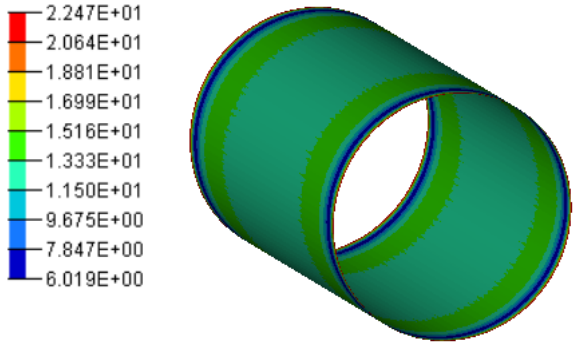
Figure 8. Optimized cylinder stresses (MPa) due to static pressure, 0.7